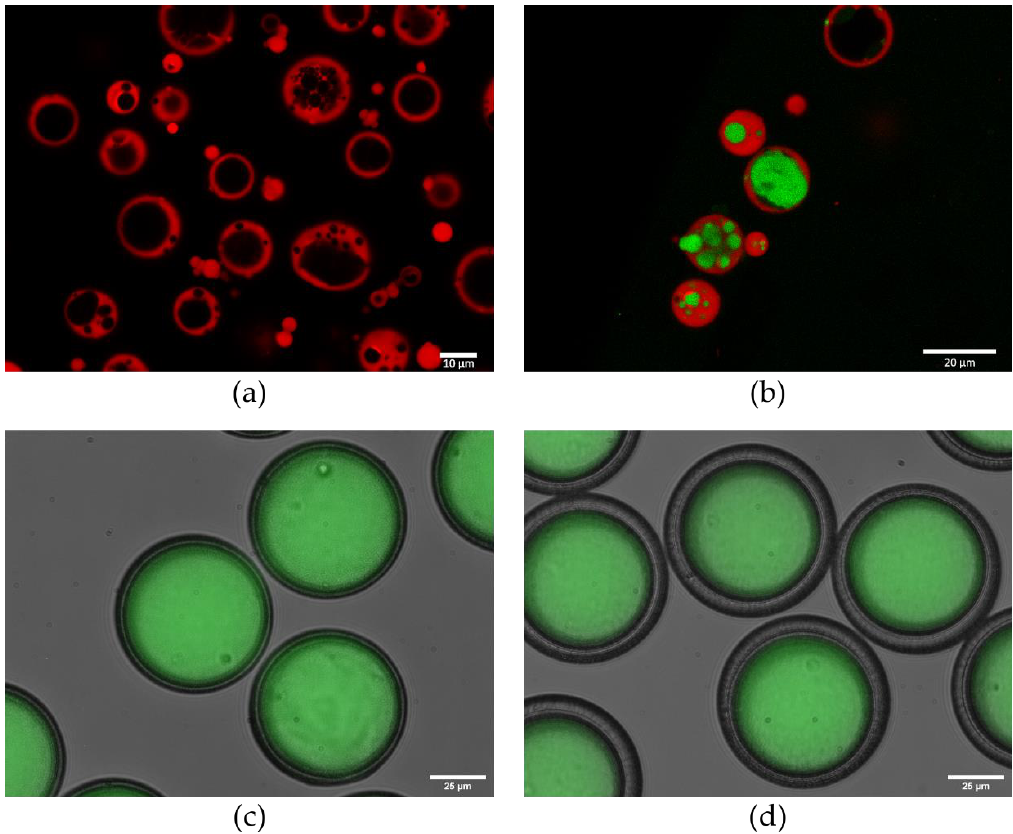
Figure 3. Core:shell microparticles prepared by two different manufacture methods. Confocal images of ( a ) the microparticles by the water-in-oil-in-water (W/O/W) method, core: sodium alginate 75–200 kDa (NovaMatrix ® ), shell: PLGA – rhodamine (50:50 30 kDa); ( b ) the microparticles by the W/O/W method, core: sodium alginate labelled with calcein, shell as in ( a ). Fluorescent microscopy images (40 × magnification) of ( c ) the thin shell microparticles by the microfluidics method, core: dextran-FITC 70 kDa, shell: PLGA resomer R502 (50:50 7–17 kDa); ( d ) thick shell microparticles by the microfluidics method (same parameters as in ( c )).